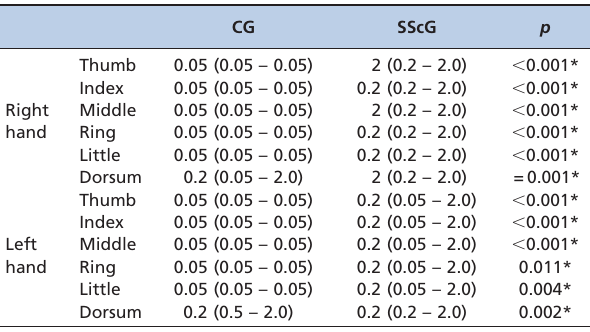
Table 3 - Results of the monofilament test for each point tested on the right and left hand of control and systemic sclerosis subjects.